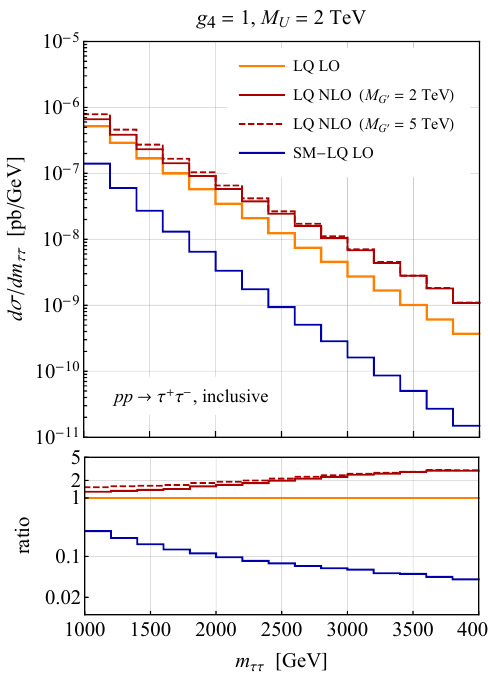
Figure 4 . Inclusive pp → τ + τ − production cross sections as a function of m ττ for the parameter choices g 4 = 1 and M U = 2 TeV . The yellow and red curves correspond to the LQ distributions at the LO (LQ LO) and the NLO (LQ NLO) in QCD, respectively, while the blue histograms illustrate the magnitude of the interference effects between the SM background and the LQ signal (SM- LQ LO). In the case of the solid (dashed) red line the coloron mass is set to M G 0 = 2 TeV ( M G 0 = 5 TeV ). The lower panel depicts the ratios between the different LQ contributions and the relevant LQ LO